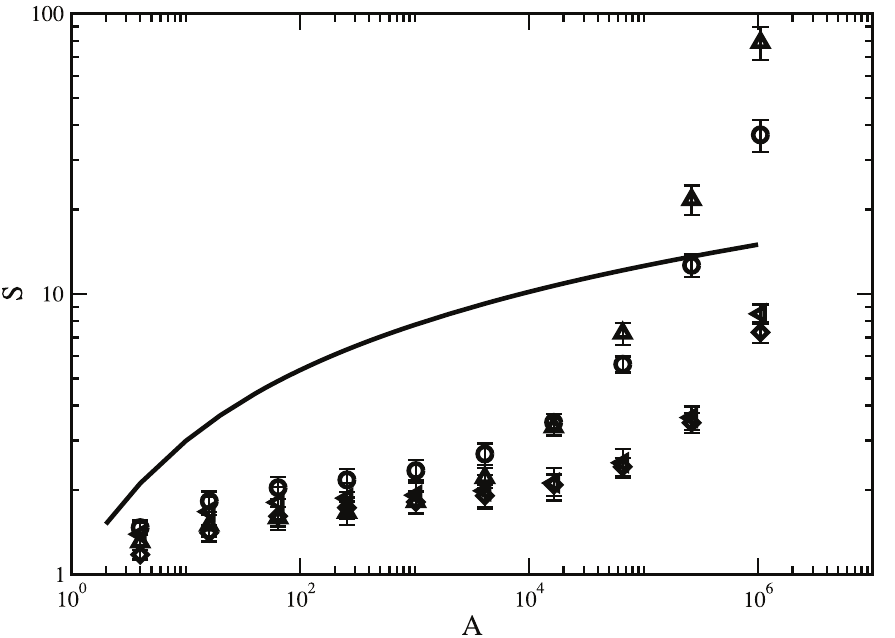
Figure 7. Species-area curves for different values of dispersal parameter. Number of species S is plotted against area for p ~ 0 : 5 and speciation rate n ~ 1 | 10 { 6 . The symbols denote diferrent set of parameter values : K ~ 10 and H ~ 0 : 1 (circles), K ~ 7 and H ~ 0 : 1 (triangles up), K ~ 10 and H ~ 0 : 9 (diamonds), K ~ 7 and H ~ 0 : 9 (left triangles). The line is the theoretical prediction for the species-area curve if dispersal is not limited as given by Eq. (5). The data points represent an average over 20 independent runs. The error bars correspond to one standard error.